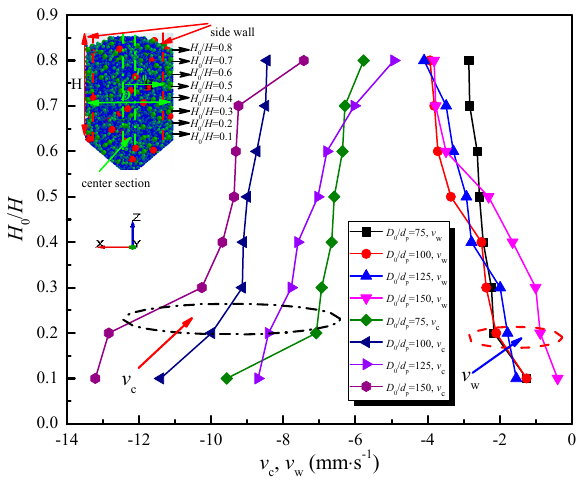
Figure 23. The variation in v w , v c along the height of sinter layers with variations in the geometry factor.